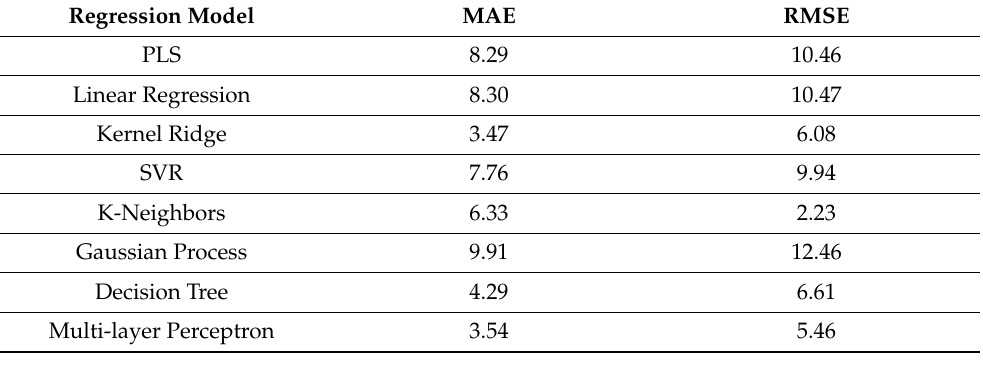
Table 2. Mean Absolute Error (MAE) and Root Mean Squared Error (RMSE).